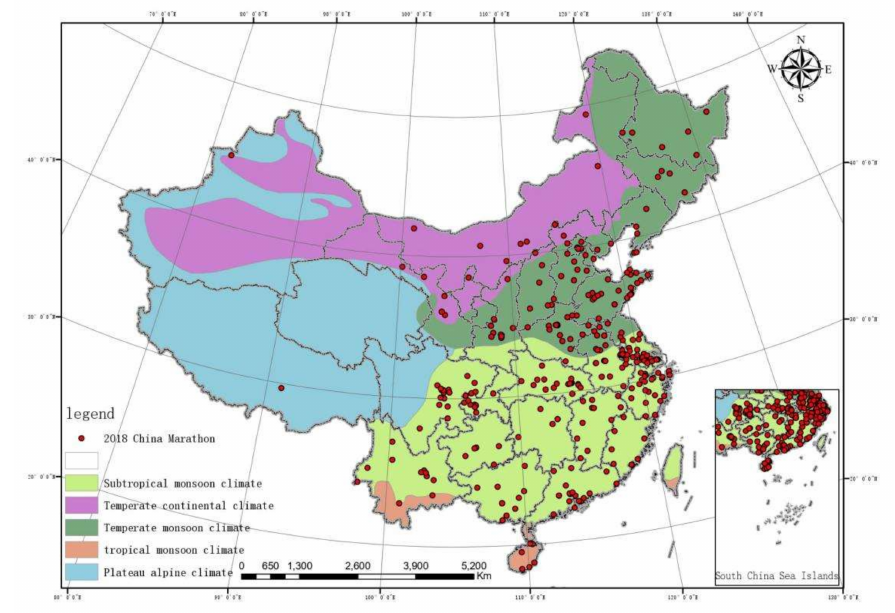
Figure 3. Climate and marathon running coupling